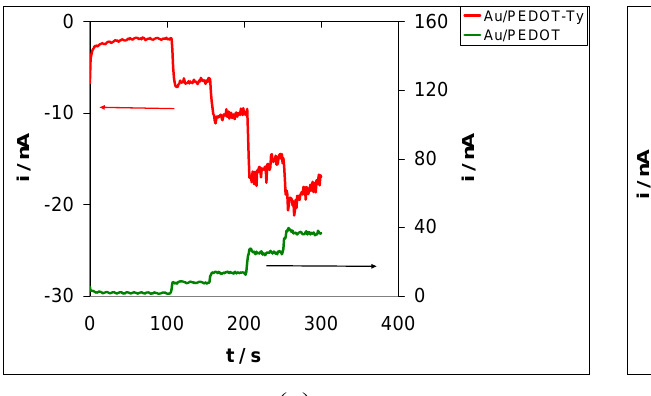
Figure 6. ( a ) Chronoamperometric responses recorded simultaneously at an Au-array/PEDOT-Ty-CA modified electrode, polarized at − 0.20 V vs. Ag/AgCl, and an Au-array/PEDOT-CA modified electrode, polarized at +0.30 V vs. Ag/AgCl, in an aqueous phosphate buffer solution of pH 7.5 at various dopamine and catechol mixture concentrations: 10, 20, 40, 60, and 80 μ M; ( b ) Calibration plots obtained from the chronomperometric responses presented in Figure